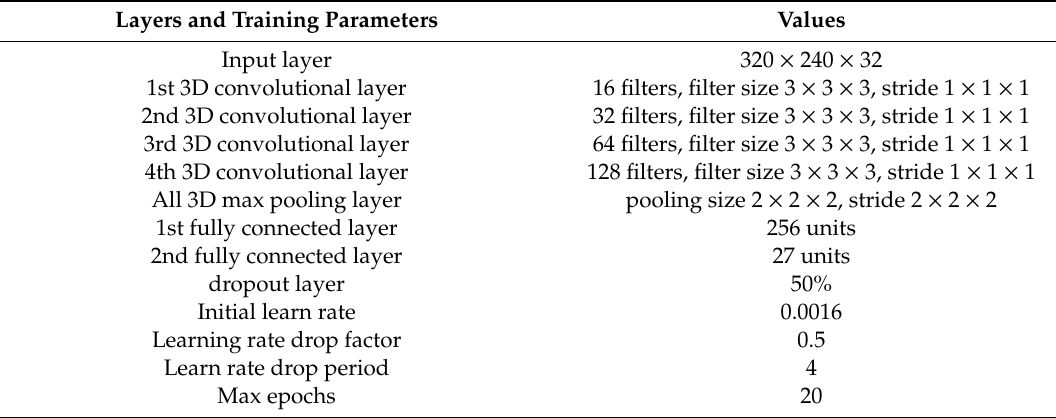
Table 2. Architecture of the 3D convolutional neural network.